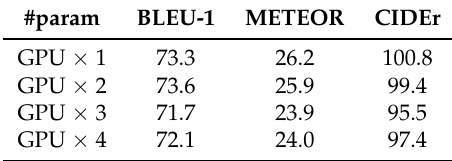
Table 3. Results comparison of multi-GPU training based on BLEU-1, METEOR, and CIDEr